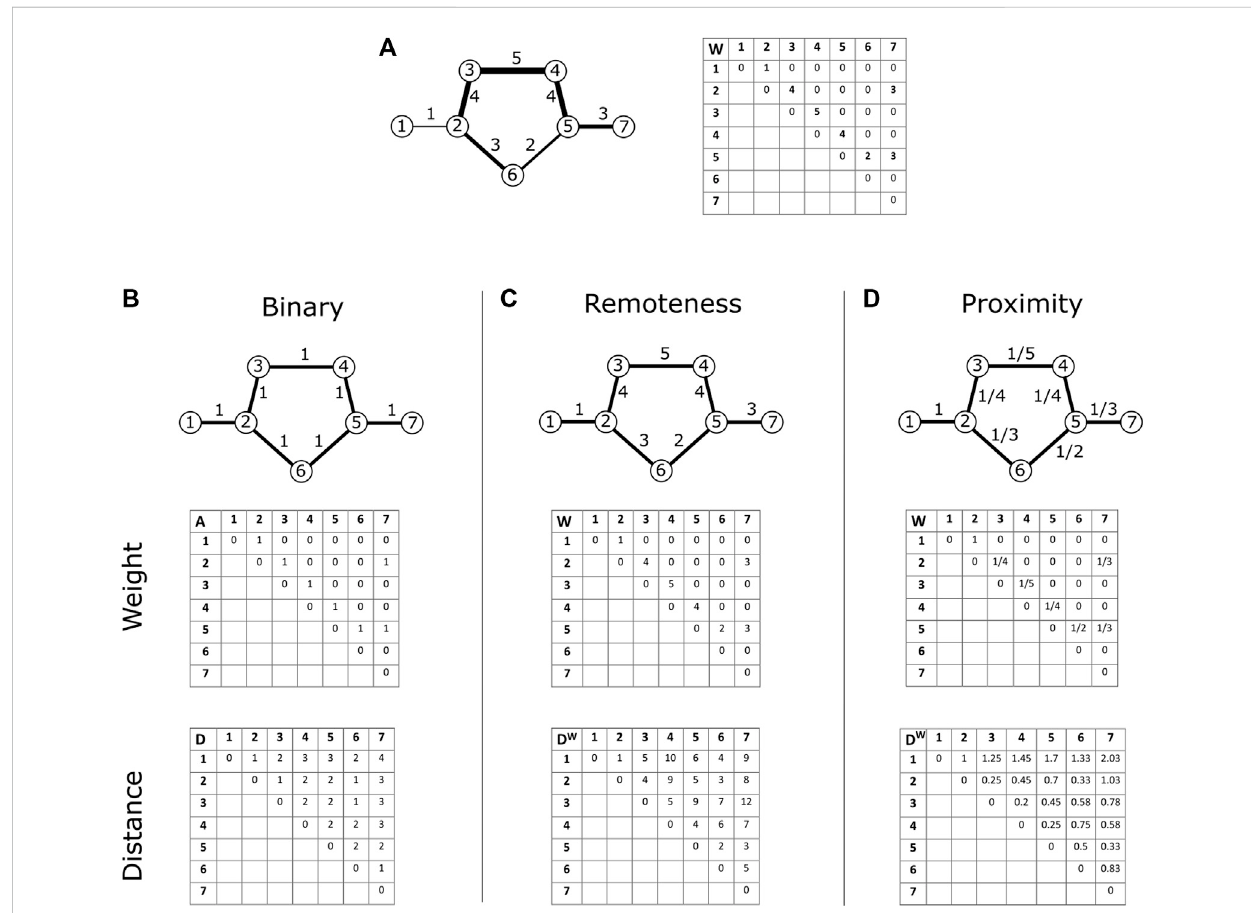
FIGURE 2 Binary and weighted node distance computational examples. (Top) Weighted network of seven nodes and seven links and its weight matrix W . (Left column) Binary network counterpart of the weighted network on top, with its adjacency matrix A and its distance matrix D of the binary node distances. (Middlecolumn)Theweightednetworkwithlinkweightasremoteness,itsweightmatrix W anditsdistancematrix D w oftheweightednodedistances d w ij . (Rightcolumn)Theweightednetworkwithlinkweightasproximity,itsweightmatrix W computedbyreciprocatingthelinkweights,anditsdistance matrix D w of the weighted node distances d w ij . The element D ij of the distance matrix indicates the distance d ij (shortest path length) between node i and node j . Since the computation is for undirected networks, we depict only the upper triangular matrix of D